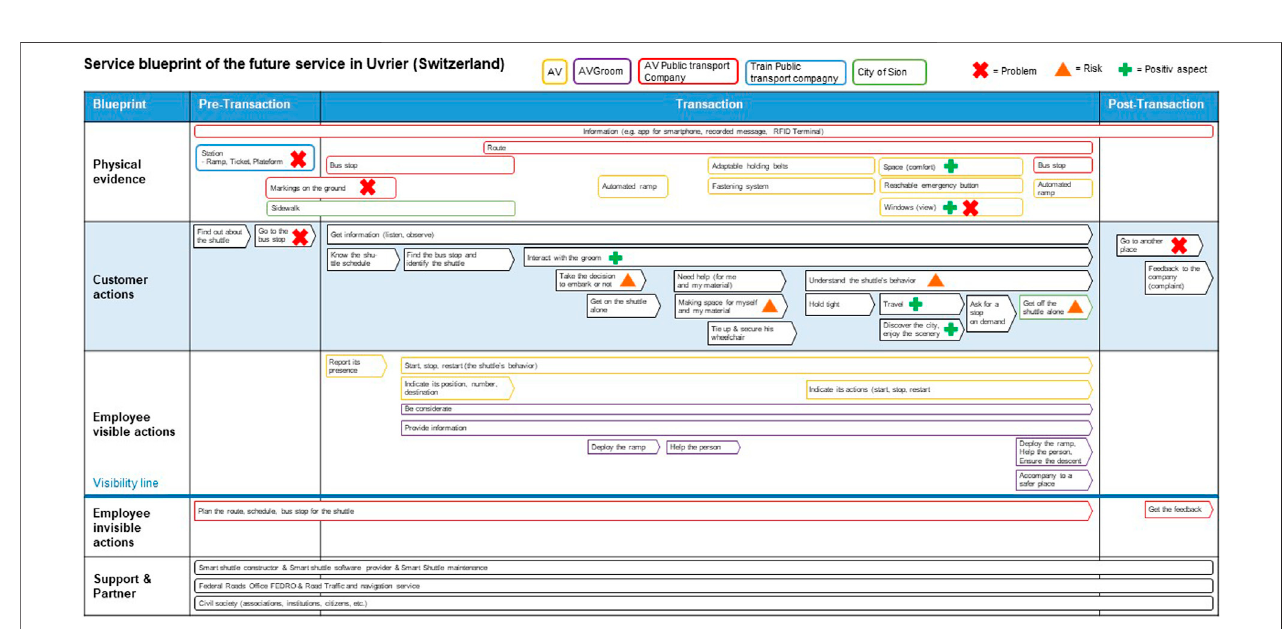
FIGURE 6 | Service blueprint of the future service in Uvrier